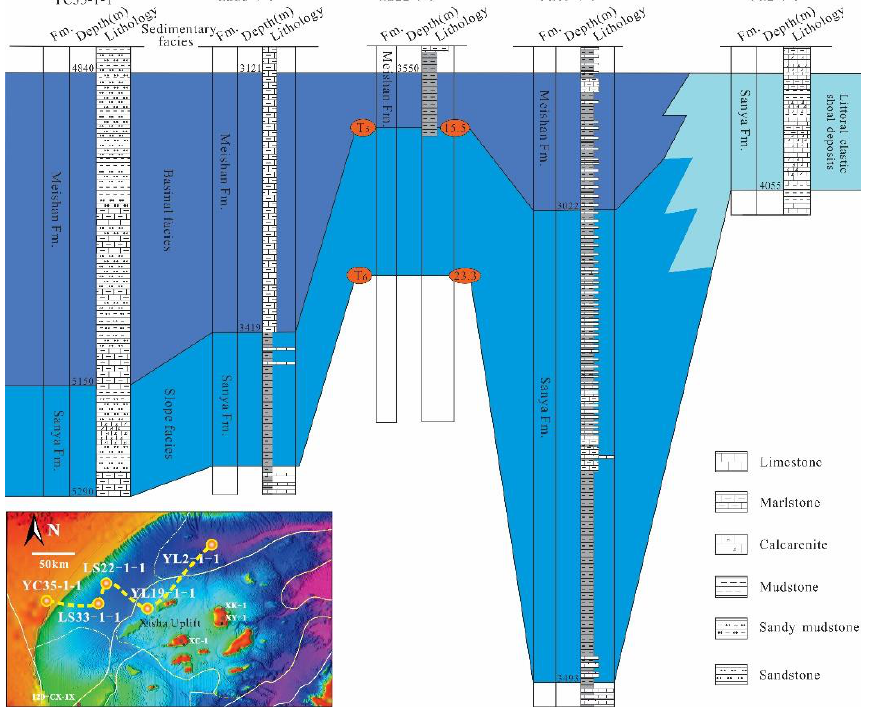
Figure 5. The cross-section of wells from Well YC35-1-1 to Well YL2-1-1 for sedimentary facies and lithological combinations in the deep-water zone of the Xisha sea area. The well locations are shown in the left corner of the scaled map in Figure